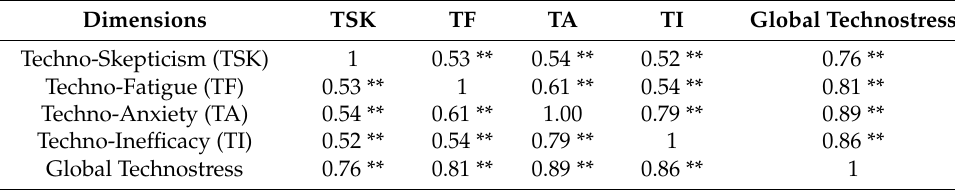
Table 3. Pearson’s correlations between the dimensions of technostress.